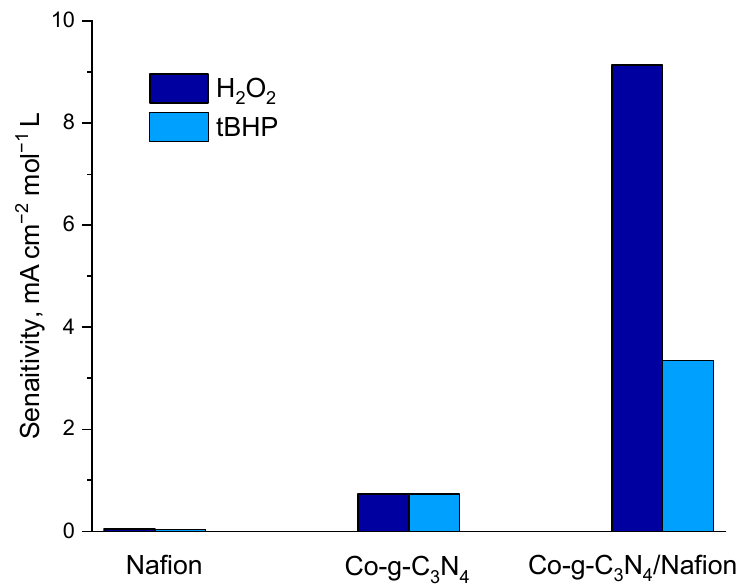
Figure 6. Electrode sensitivity determined at a constant potential of − 0.2 V (vs. Ag|AgCl, sat. KCl or − 0.415 V vs. RHE) for different electrode modifications: 0.2% Nafion—coated GCE; electrode modified with Co-g-C 3 N 4 layer (2 mg/mL dispersed in water); and electrode modified with Co-g-C 3 N 4 /Nafion suspension (catalyst load 0.01 mg); working potential − 0.2 V ( − 0.002 V vs. SHE); pH = 7.0, room